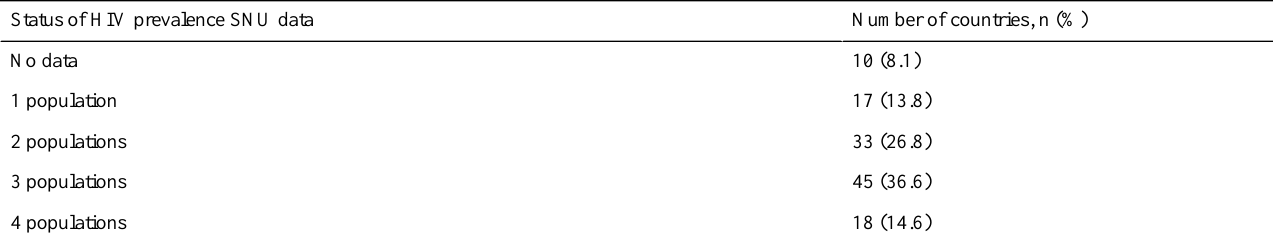
Table 2. Number and proportion of countries distributed by number of KPs a with HIV prevalence SNU b data (2001-2017;